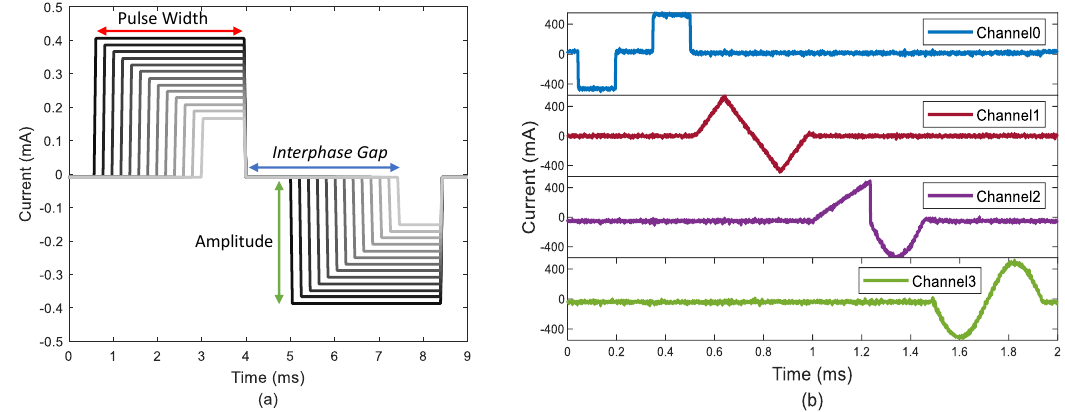
Figure 6. ( a ) Pulse width, interphase gap, and amplitude for both positive and negative pulse are customizable and ( b ) arbitrary waveform done using lookup table update.